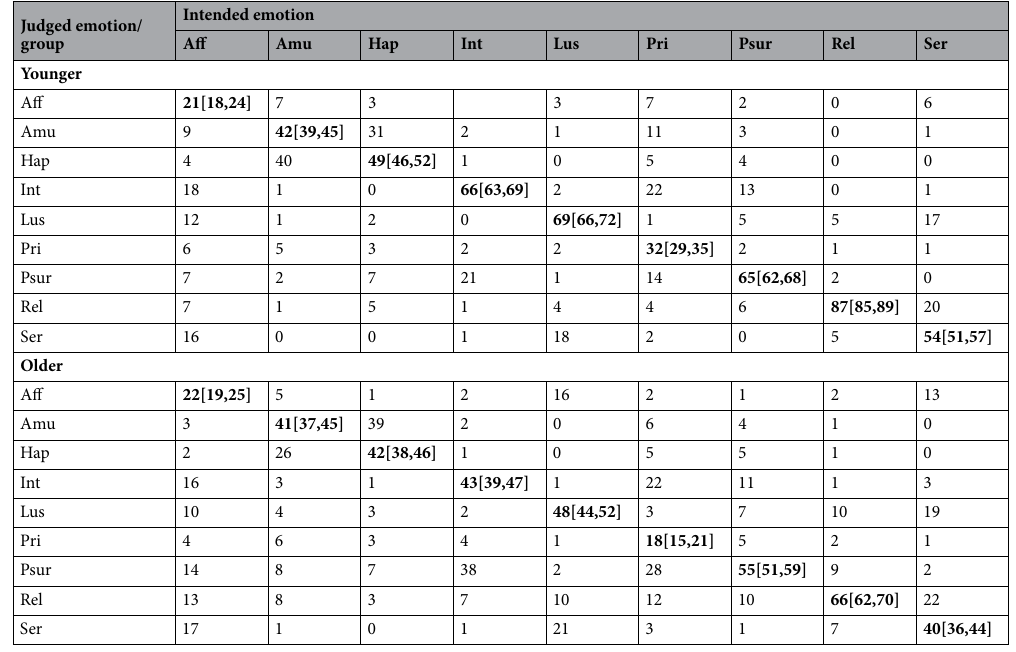
Table 2. Confusion matrix showing the proportion of judgments in Task 2 (positive nonlinguistic vocalizations) for each intended emotion and for both age groups. Diagonal cells represent the percentage of correct responses (marked in bold typeface). Numbers in brackets indicate 95% CIs. Aff affection, Amu amusement, Hap happiness, Int interest, Lus lust, Pri pride, Psur positive surprise, Rel relief, Ser serenity.